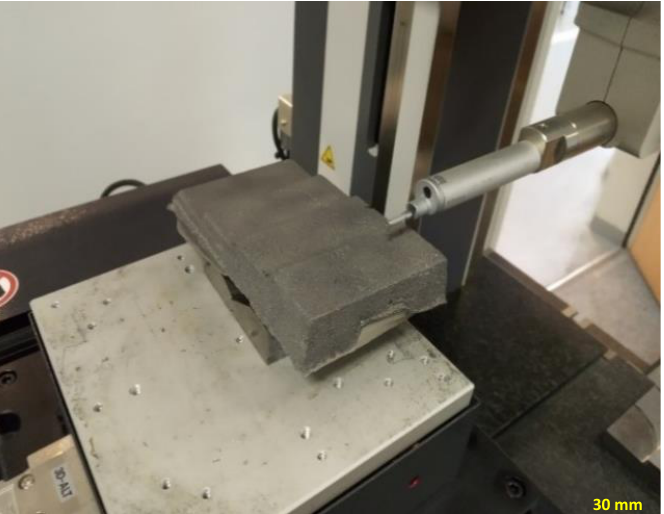
Figure 2. MITUTOYO CV-3200 profilometer and view of the analyzed stair cast (the roughness of each “stair” was individually measured using a needle measurement).